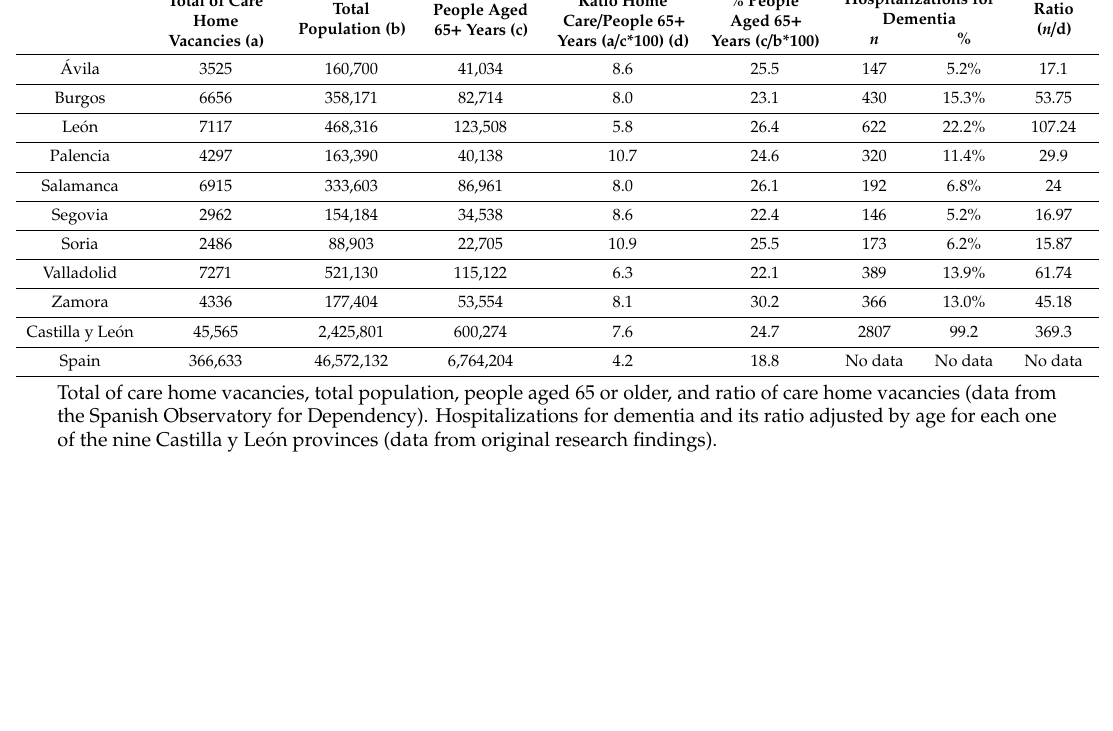
Table 4. Socio-health care benefits for dementia in Castilla y Le ó n and hospitalization rates for dementia. Total of Care